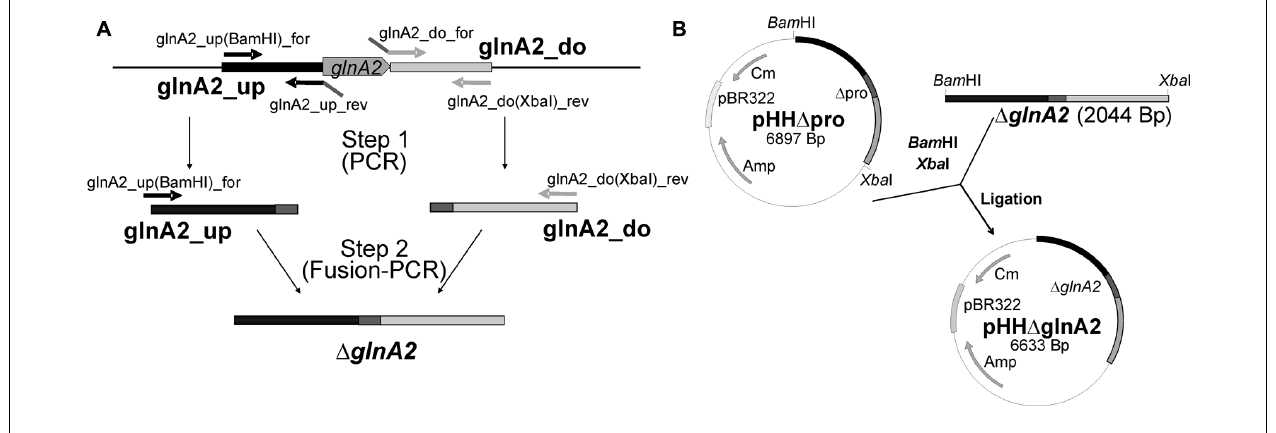
FIGURE 1 | Construction of pHH (cid:2) glnA2 . For construction of the non- replicating plasmid pHH (cid:2) glnA2 for the deletion of glnA2 1.0 kbp regions upstream and downstream of glnA2 were amplified and merged by using